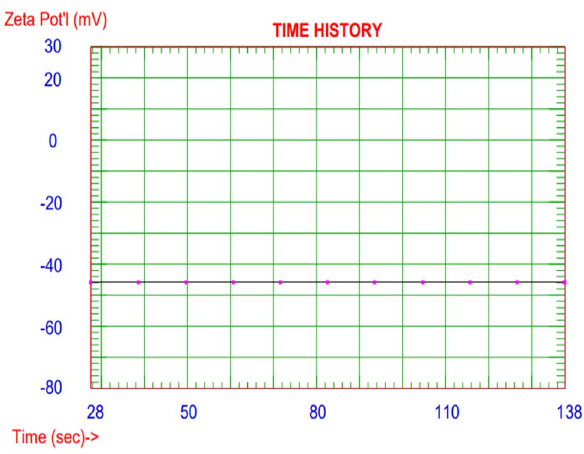
Figure 4. Zeta potential measurement of the prepared